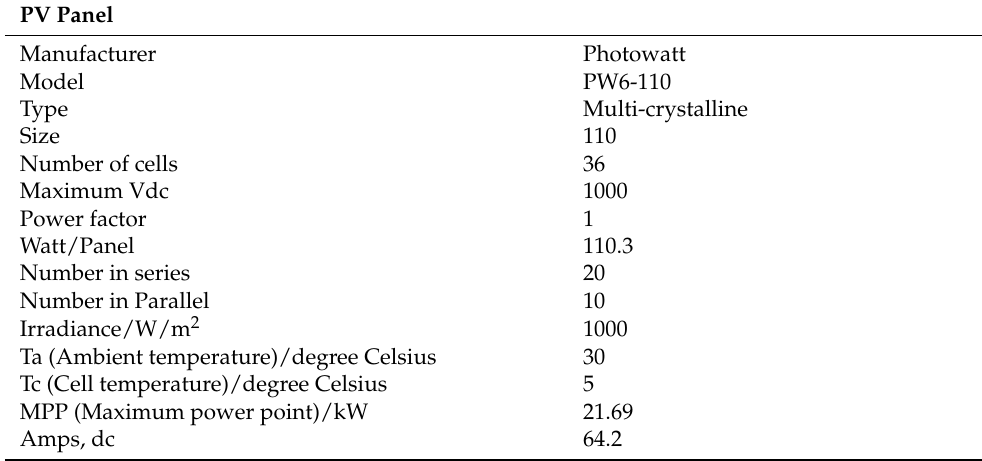
Table 4. Solar PV parameters used for modelling PV panel obtained from ETAP software. PV Panel